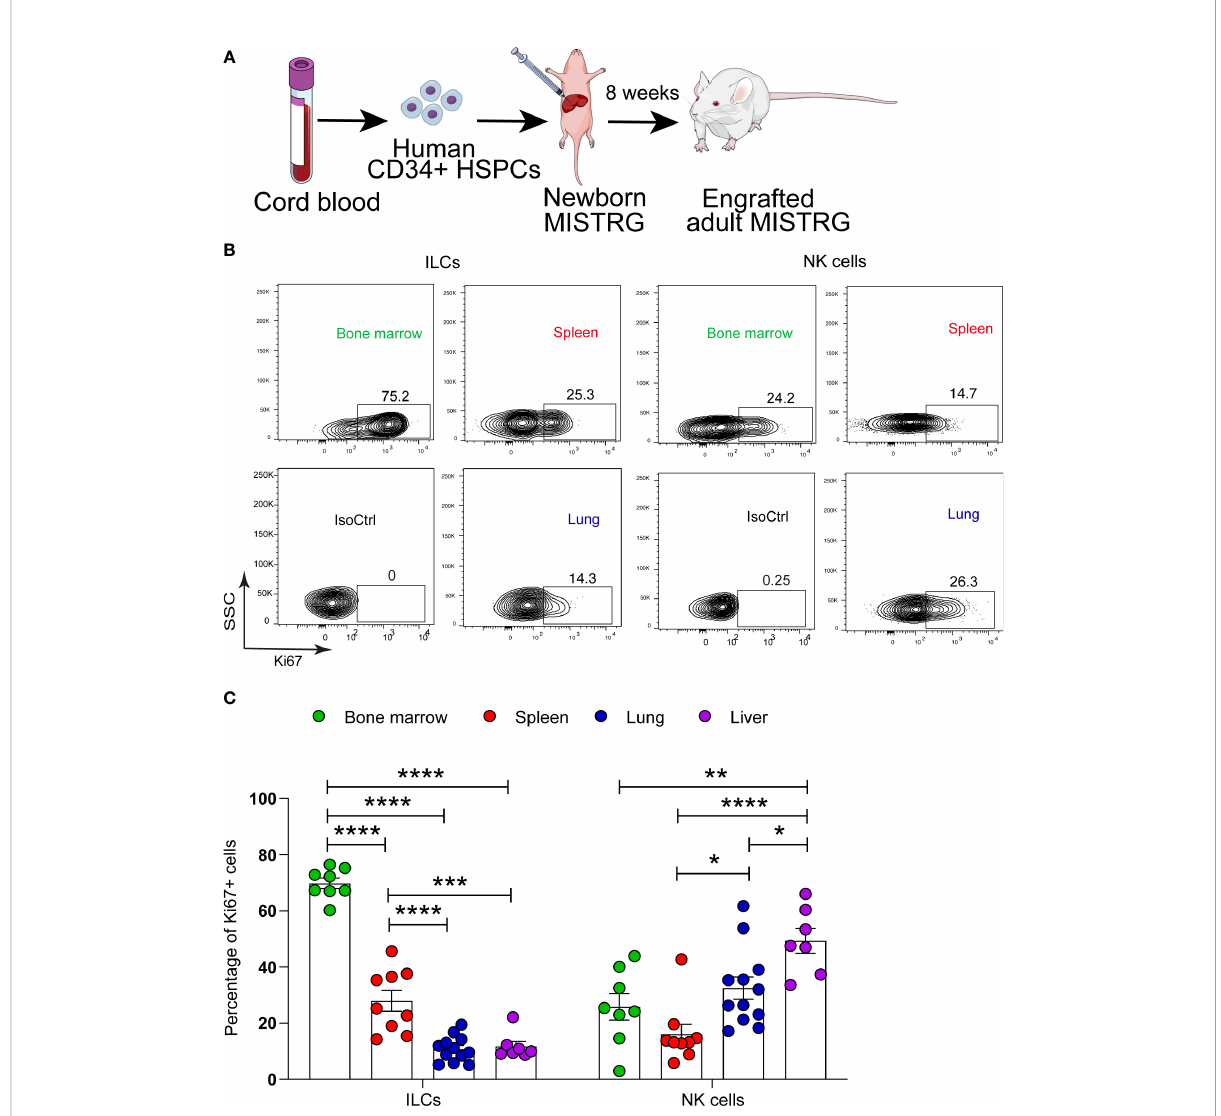
FIGURE 1 Proliferative status of human ILCs in lymphoid and non-lymphoid organs of HSPC-engrafted MISTRG mice. (A) Transplantation of newborn MISTRG mice with human CD34 + cord blood HSPCs. (B, C) Intracellular Ki67 expression by human ILCs and NK cells as determined by fl ow cytometry. Isotype control (IsoCtrl) staining is shown for the lung. ILCs were gated as human CD45 + CD127 + CD94 - CD3 - TCR ab - Lin - cells and NK cells were gated as human CD45 + CD127 - CD94 + CD3 - TCR ab - Lin - cells as in Supplementary Figure 1. For bone marrow analysis, ILCs and NK cells were also gated as CD34 - cells. Frequencies of Ki67 + ILCs and NK cells in the indicated organs of HSPC-engrafted MISTRG mice (n = 7-12) are shown in (C) . *, P <0.05; **, P < 0.01; ***, P <0.001; ****, P < 0.0001 by one-way ANOVA, Tukey ’ s post-test. Data are represented as mean ± SEM. Data are from two independent experiments using MISTRG mice engrafted with different pools of HSPCs. (A) was created with Mind the